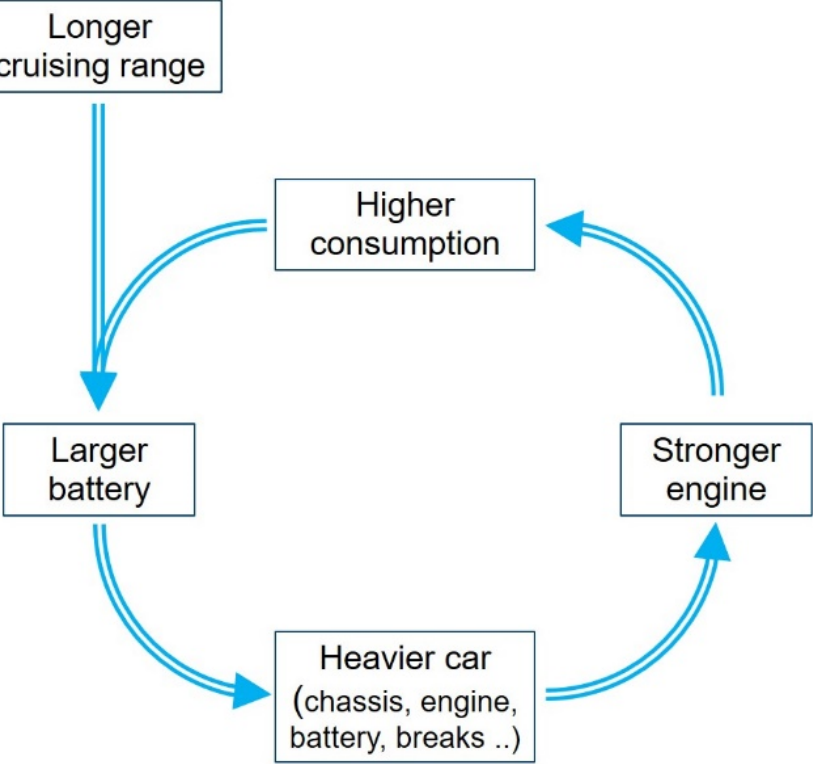
Figure 1. Factors leading to higher vehicle weight.